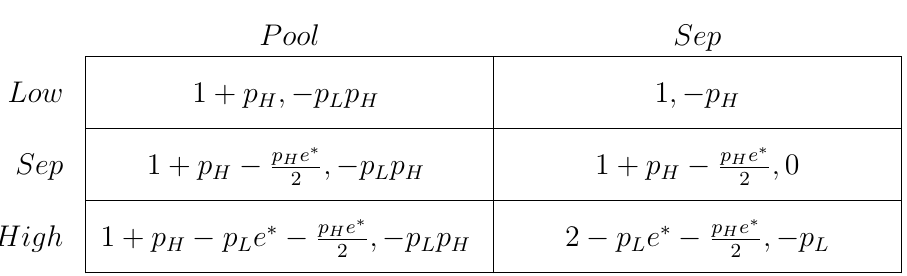
Figure 2. Best response correspondences for the pruned Spence signaling game with (a) 1 < e ∗ < 2 and (b) 0 < e ∗ < 1 . The sender’s best reply is shown by the thick line. The receiver’s best reply is shown by the translucent surface. x signifies the probability that the 2 sender plays Sep , x the probability that the sender plays High , and y the probability that 3 2 the receiver plays Sep . Nash equilibria are highlighted by black